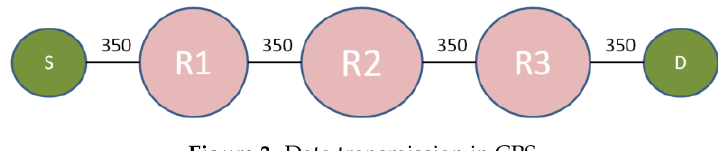
Figure 3. Data transmission in CPS.